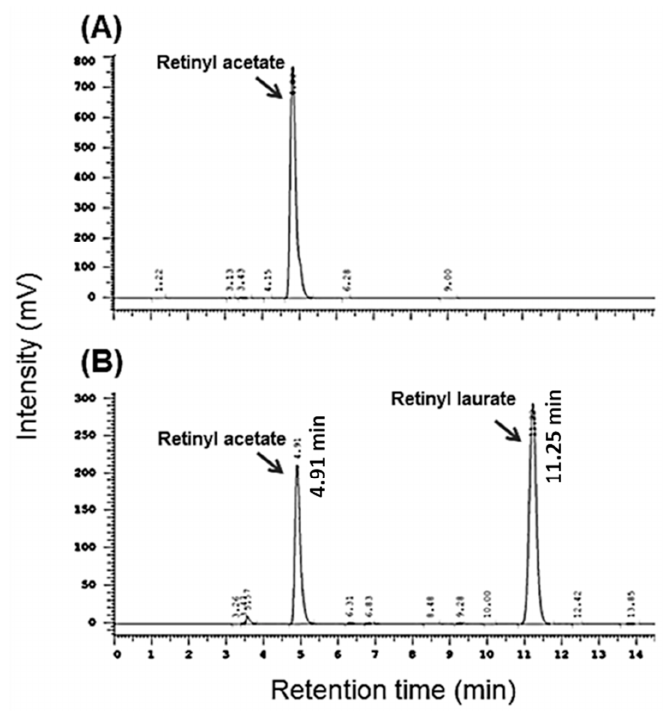
Figure 9. HPLC chromatogram of retinyl laurate. ( A , B ) show the chromatograms obtained before and after the lipase-catalyzed reaction, respectively.